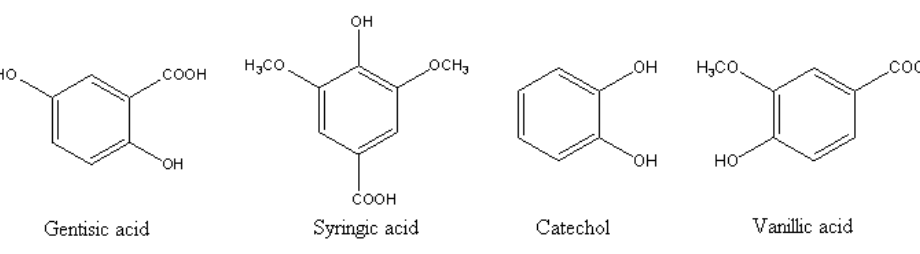
Figure 4. Four phenolic allelochemicals isolated from Eucalyptus [23]